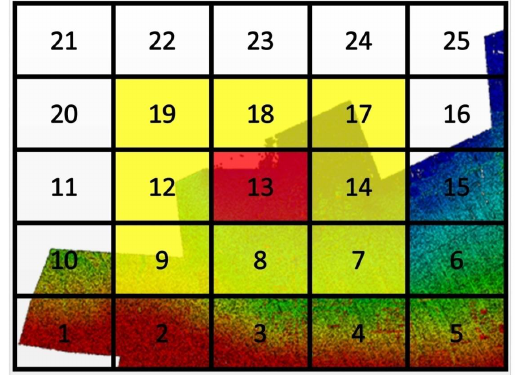
Figure 3. An example of the partition strategy of the LiDAR data.